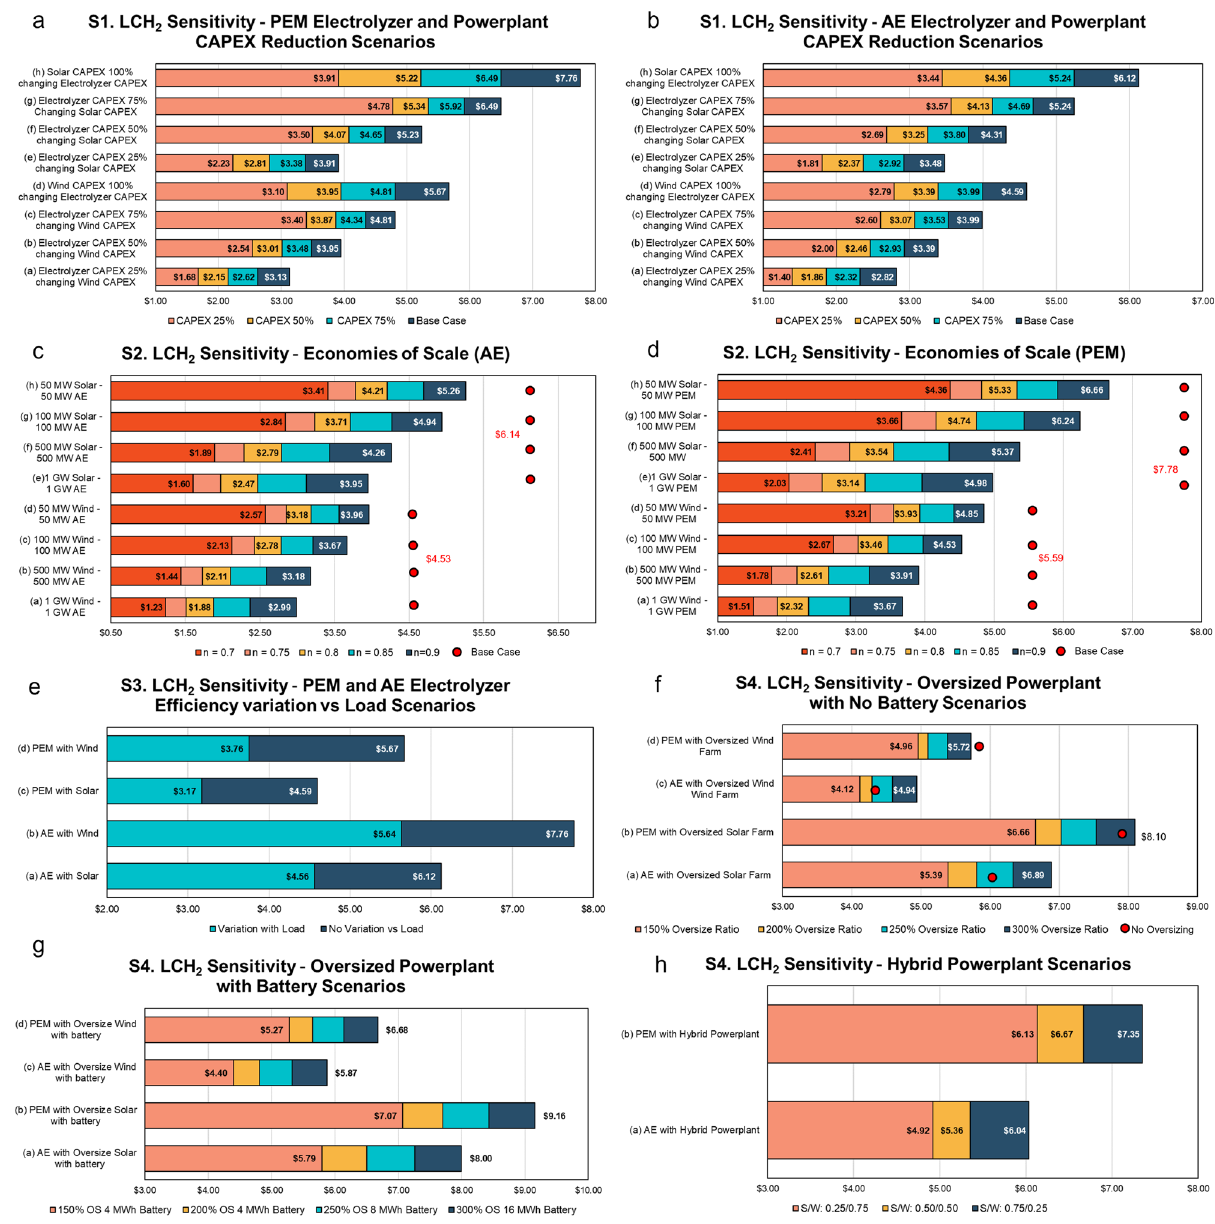
Fig. 5 Sensitivity analysis results. The sensitivity was conducted for the scenarios; S1 — capital cost reduction for both a AE and b PEM electrolyzer system and the powerplant, S2 — economies of scale for both c AE and d PEM system as well as the powerplant, e S3 — ef fi ciency variation vs load for both class of electrolyzers and S4 — electrolyzer and powerplant designs with f oversized powerplants without BESS, g oversized powerplants with BESS, and h hybrid powerplants with varying share of solar and wind for both AE and PEM systems respectively. These scenarios are elaborated in Supplementary Table 8 with base case cost assumptions adapted from Supplementary Table 7. Additional results for categories S3 — ef fi ciency improvement and S4 — electrolyzer and powerplant design scenarios, that are not represented here are grouped in Supplementary Fig. 18. Here the solar and wind traces of Geraldton was used as an example representation. Note the values are all in